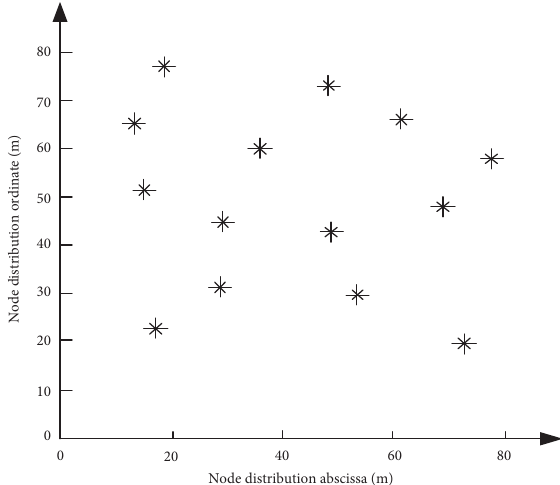
Figure 17: Experimental results of node initialization performance of the comparison method.